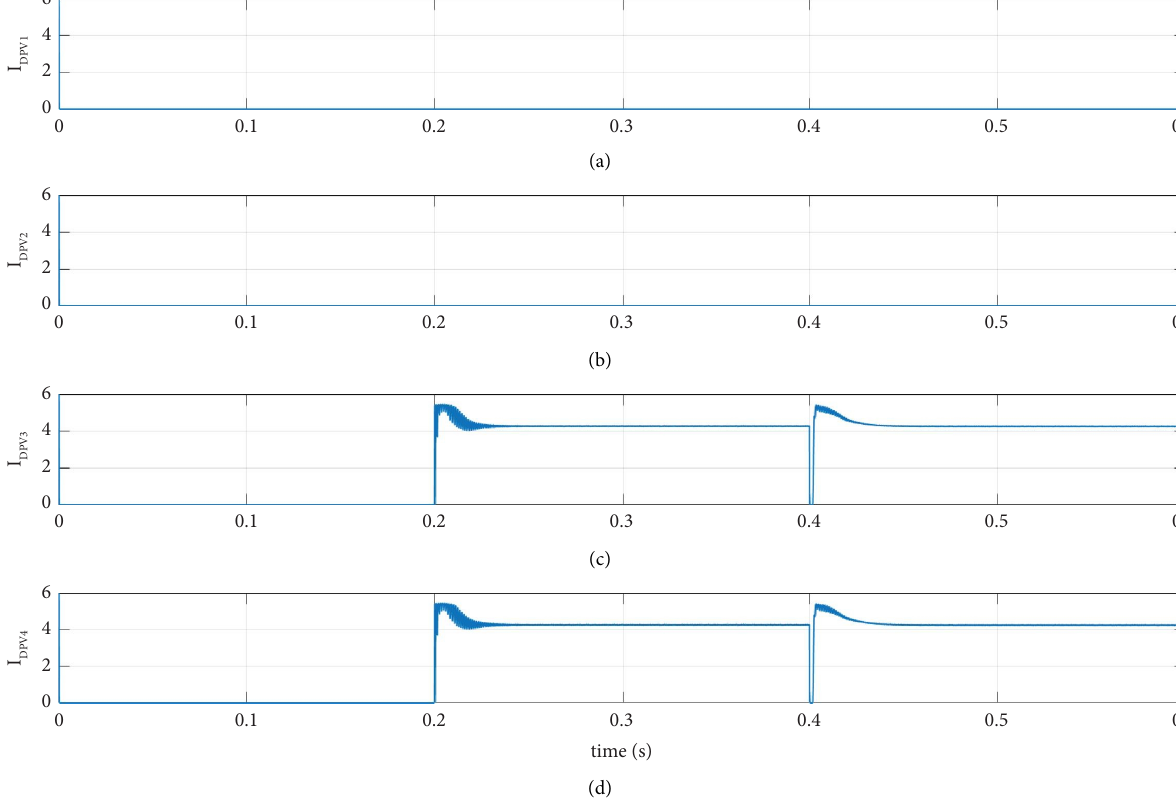
Figure 10: Simulation results (a) bypass diode PV -1 (b) bypass diode PV -2 (c) bypass diode PV -3 (d) bypass diode PV